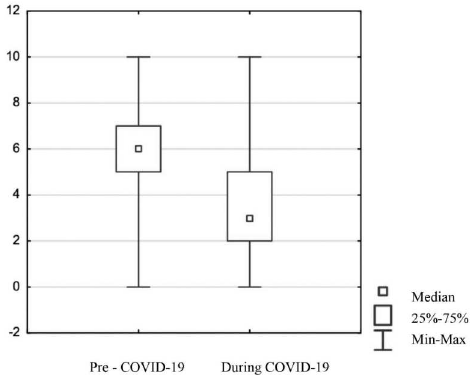
Figure 5. Comparison of scores concerning the access to health services before and during the COVID-19 pandemic among men